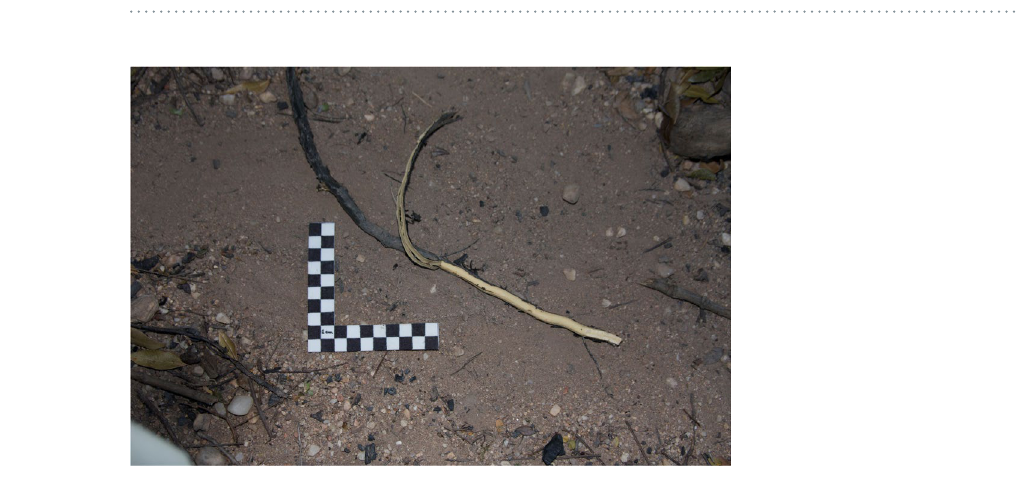
Figure 3. Thiloa glaucocarpa underground storage organs (USOs). Scale: 10 cm.